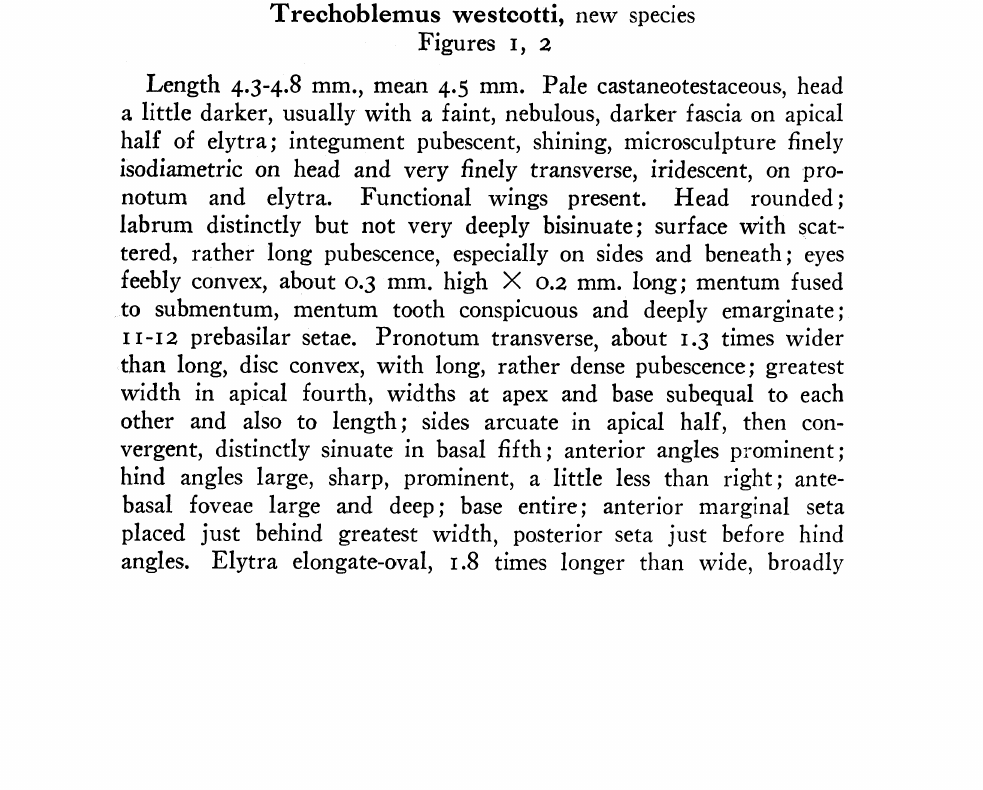
Figure 2. Trechoblemus estcotti, new species. Hillsboro, Washington County, Oregon. Aedeagus of holotype male, length 0.92 mm., left lateral